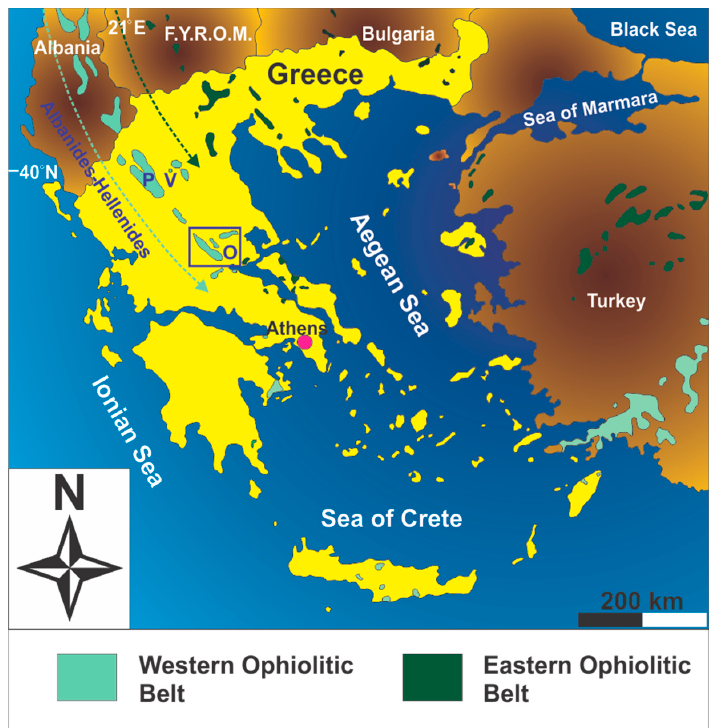
Figure 1. Distribution of ophiolites in the southernmost part of the Balkan Peninsula (modified after [30]). Key to lettering: V = Vourinos; P = Pindos; O = Othris (also marked by the open square). The initials F.Y.R.O.M. stand for Former Yugoslav Republic of Macedonia.